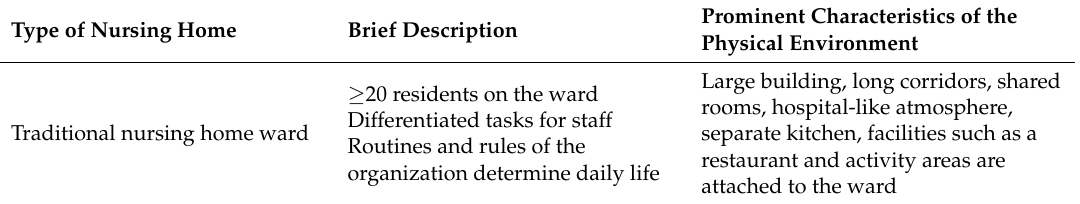
Table 1. Description of the types of nursing